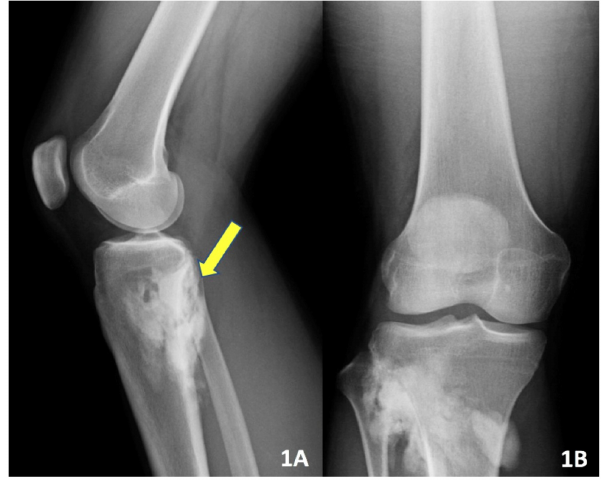
Figure 1. Pre-op lateral (A) and AP (B) x-ray imaging demonstrating an irregular osseous lesion of the right proximal tibia and fibula.